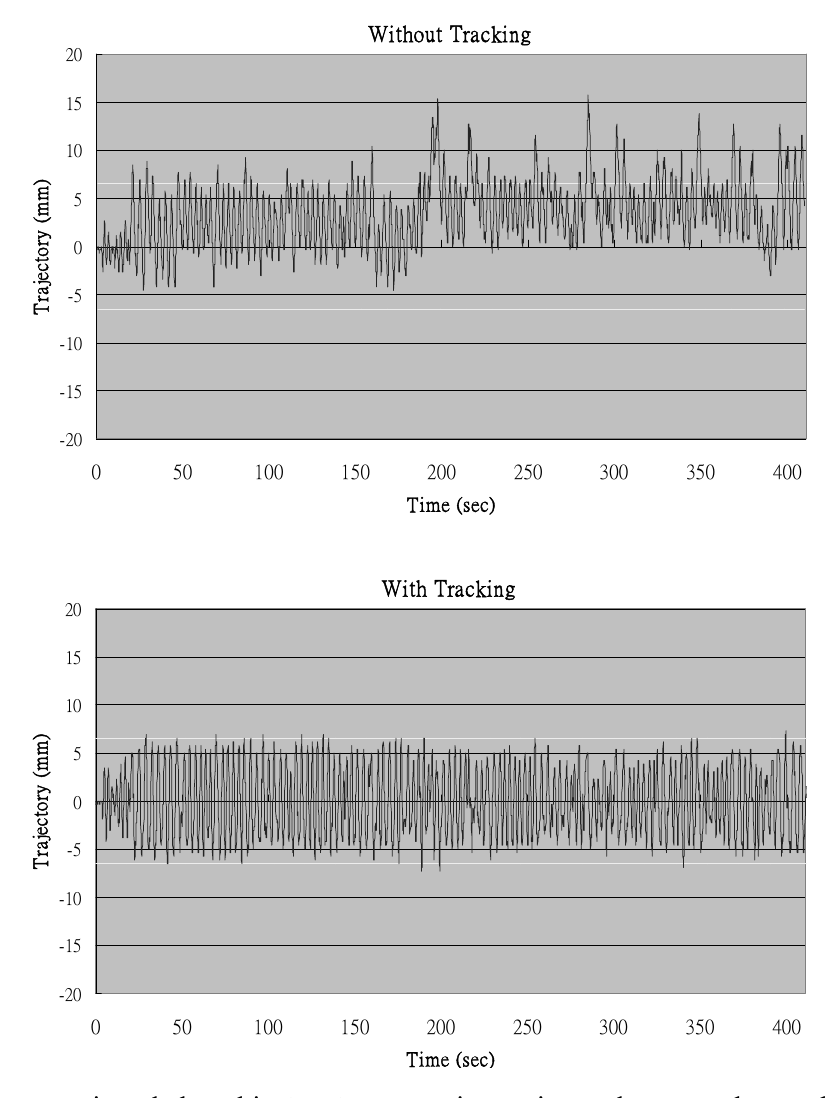
Figure 9. The trajectories of the model stone’s center in the US images with and without